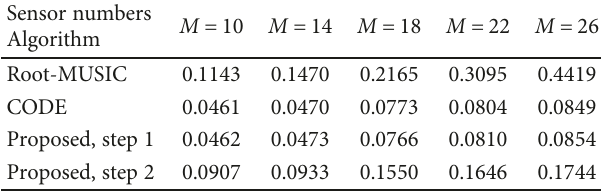
Table 3: Comparison of simulation time in